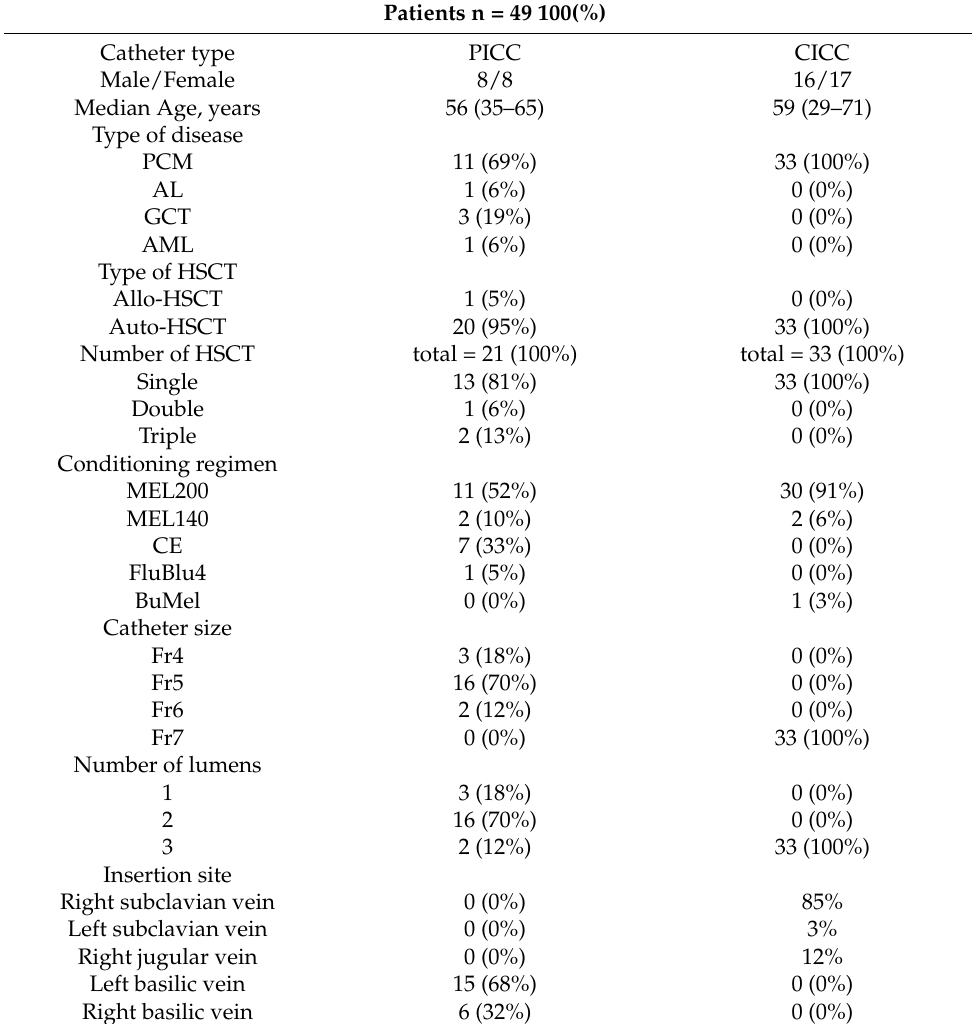
Table 1. Characteristics of the study